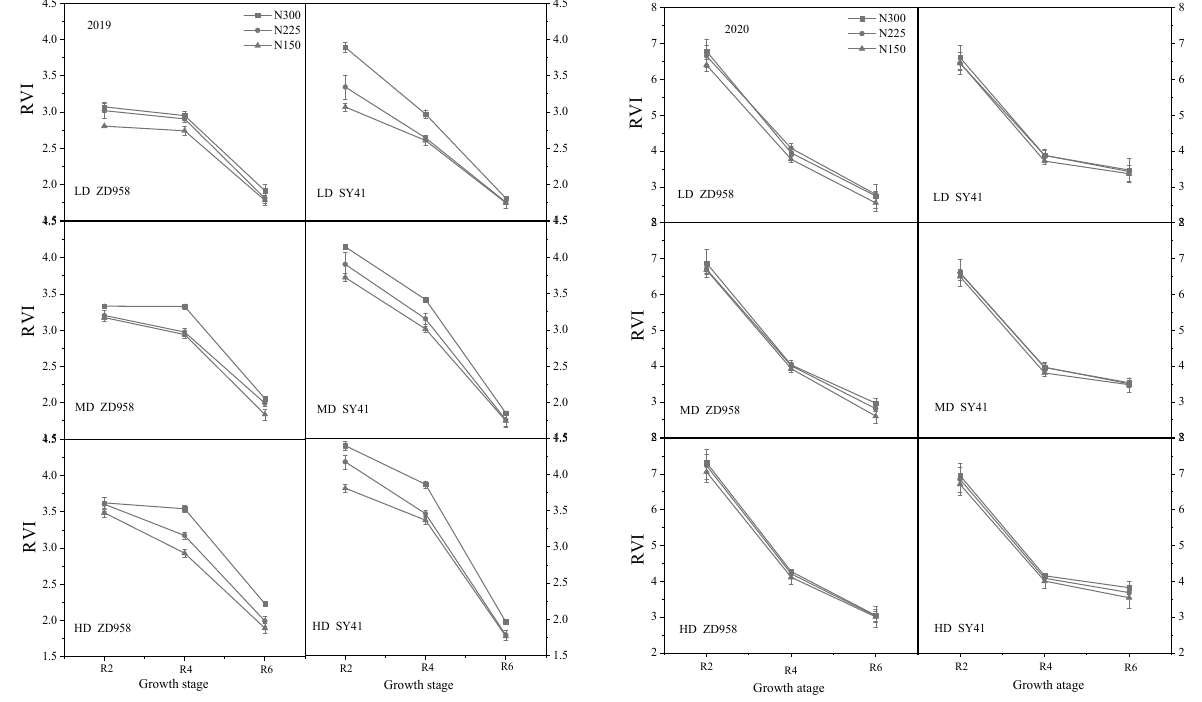
Figure 5. Effects of decreasing N rates under different planting densities on RVI in 2019 and 2020.